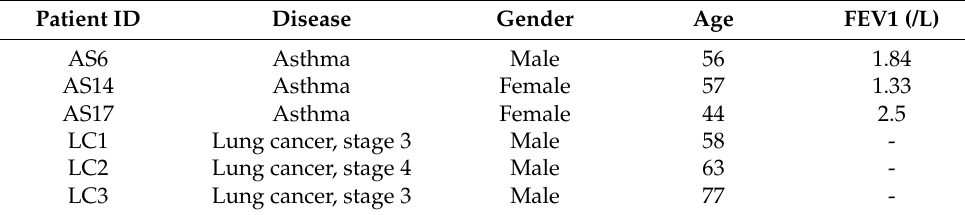
Table 3. Characteristics of the patients from whom blood samples were collected. Patient